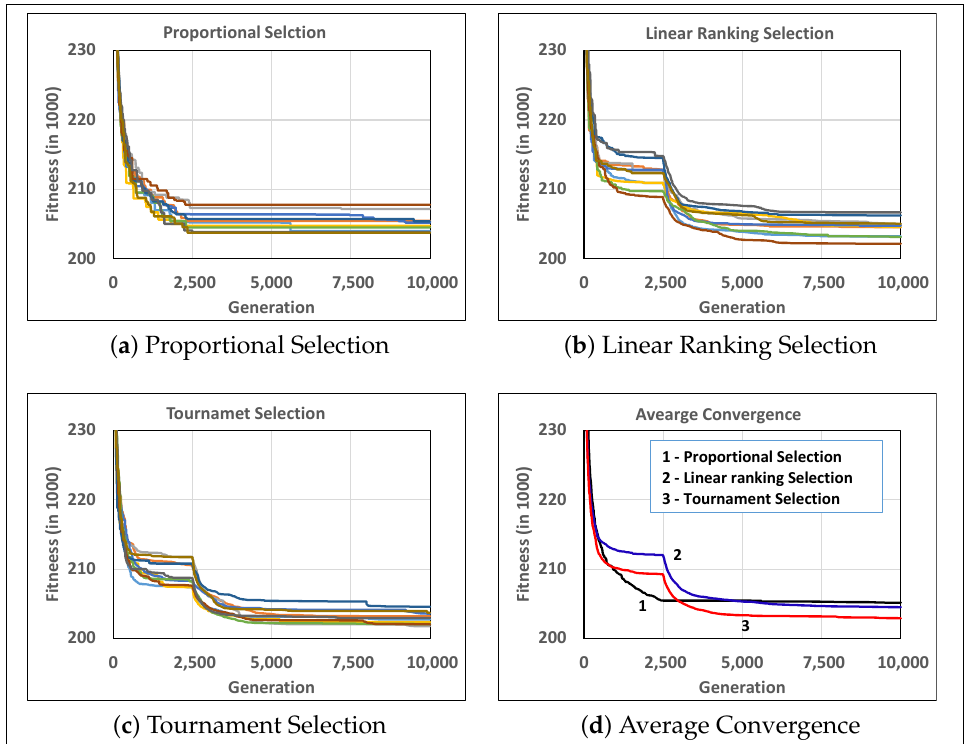
Figure 18. The convergence of 2SGA under three different selection operators while solving